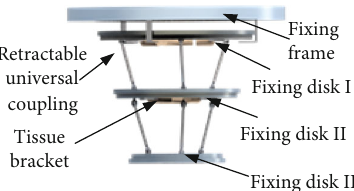
Figure 3: Structure of breast fi xation device.